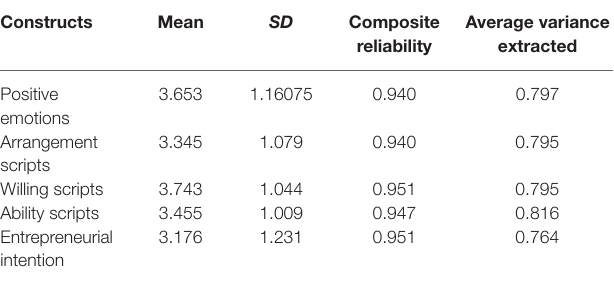
TABLE 4 | Reliability and convergent validity.